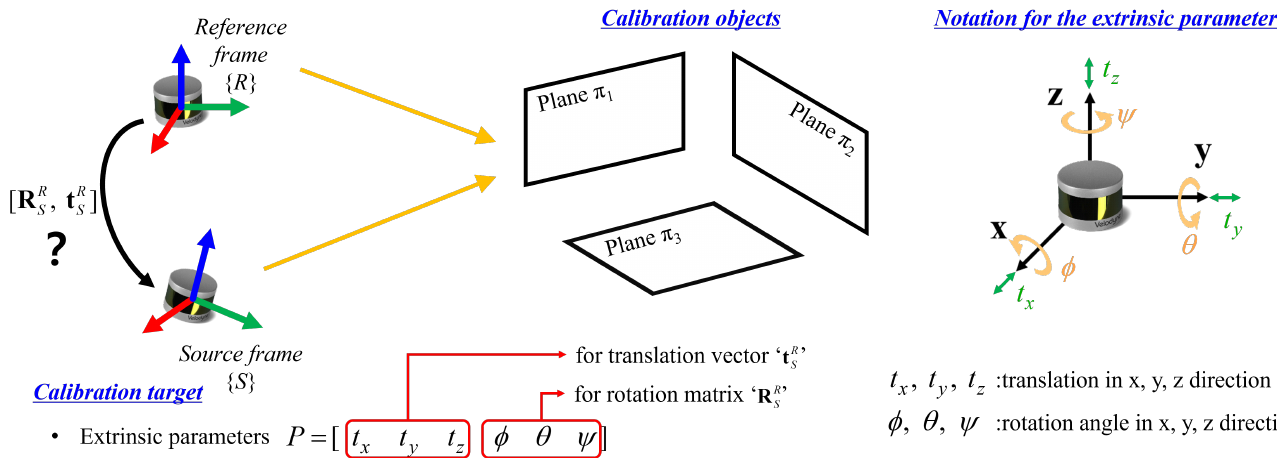
Figure 1. Problem statement for the proposed method. The aim of this research is to find extrinsic parameters that relate to the transformation between reference and source LiDAR sensors. The proposed method requires at least three non-parallel planes within the common field of view of the LiDAR